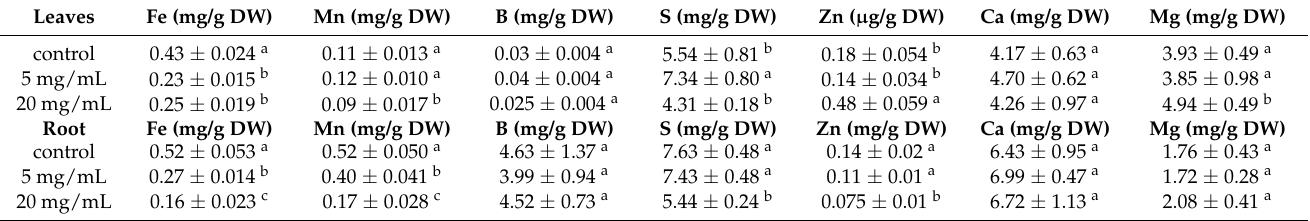
Table 2. The content of nutrient elements in the roots and leaves of tomato seedlings after exposure to C. camphora extract for 14